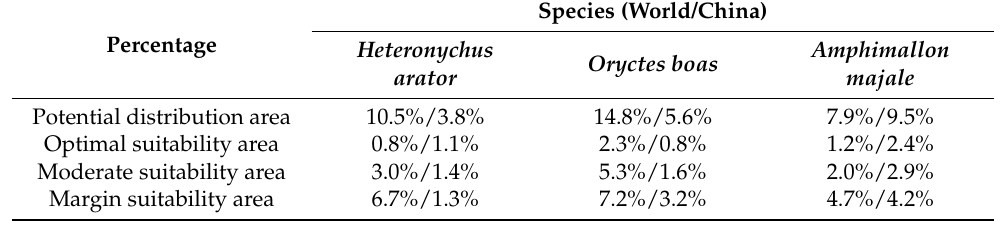
Table 3. Percentage of the potential distribution area for Heteronychus arator , Oryctes boas and Amphimallon majale .